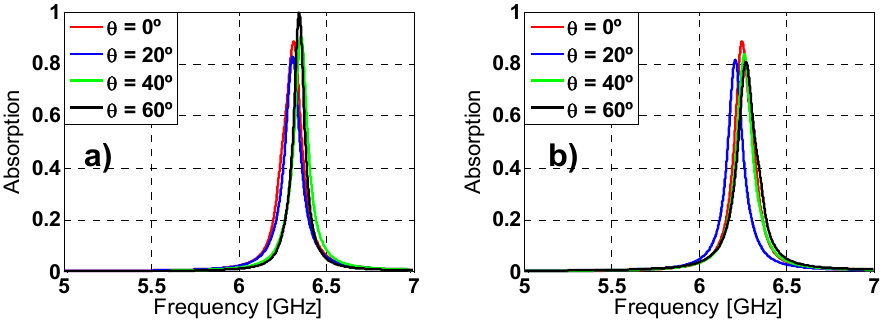
Figure 10. Absorption simulation results under different incident angles ( θ ) for both ( a ) TE and ( b ) TM